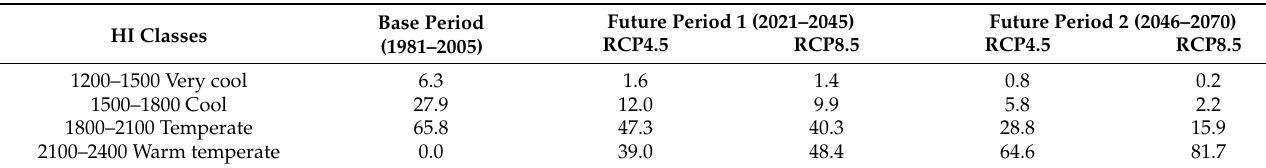
Table 4. Area (%) corresponding to various classes of the Huglin index for the Sevastopol region for two future periods under different RCP.